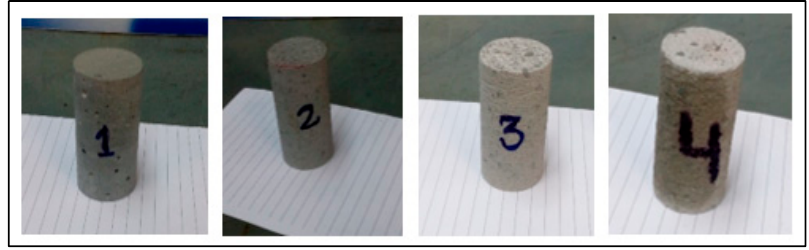
Figure 2. Cement mortar samples (length: 2.0 ˝ and dia: 1.0 ˝ ) prepared for experimental work.